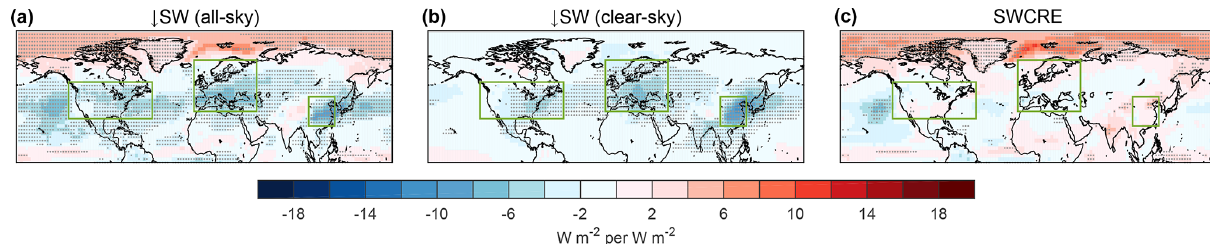
Figure 8. Changes in SW flux per unit negative forcing under all-sky (a) and clear-sky (b) conditions as well as their difference (c) for the SO 4